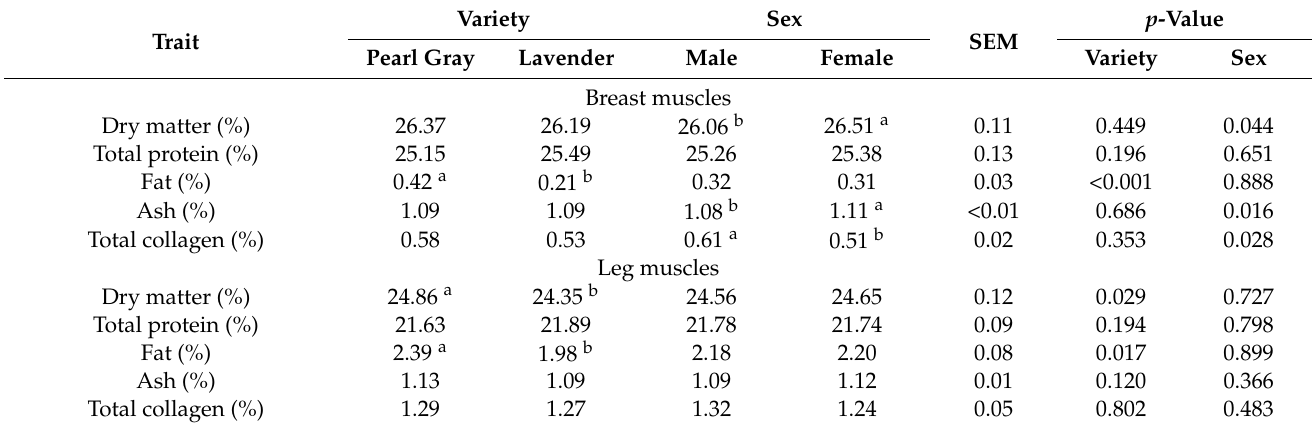
Table 3. Basic chemical composition of breast and leg muscles of male and female guinea fowl of pearl gray and lavender varieties (means ± SEM).